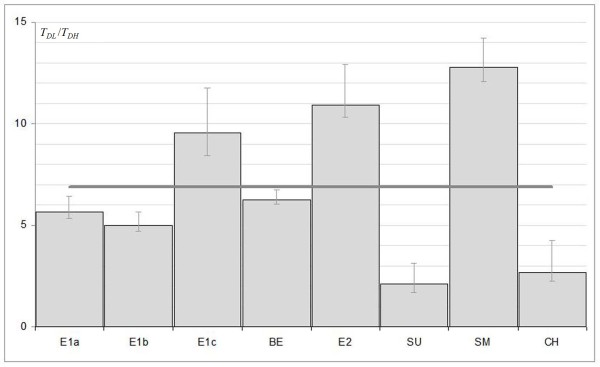
Histogram of ratios between TDvalues in the LEGFrand HEGFr groups. The error bars represent the 95% confidence intervals while the overlay trend line represent the average of values. Abbreviations: E1 = Eriksen from AO, E2 = Eriksen RO, BE = Bentzen JCO, SU = Suwinski IJROBP, SM = Smid IJROBP, CH = Chung IJROBP.